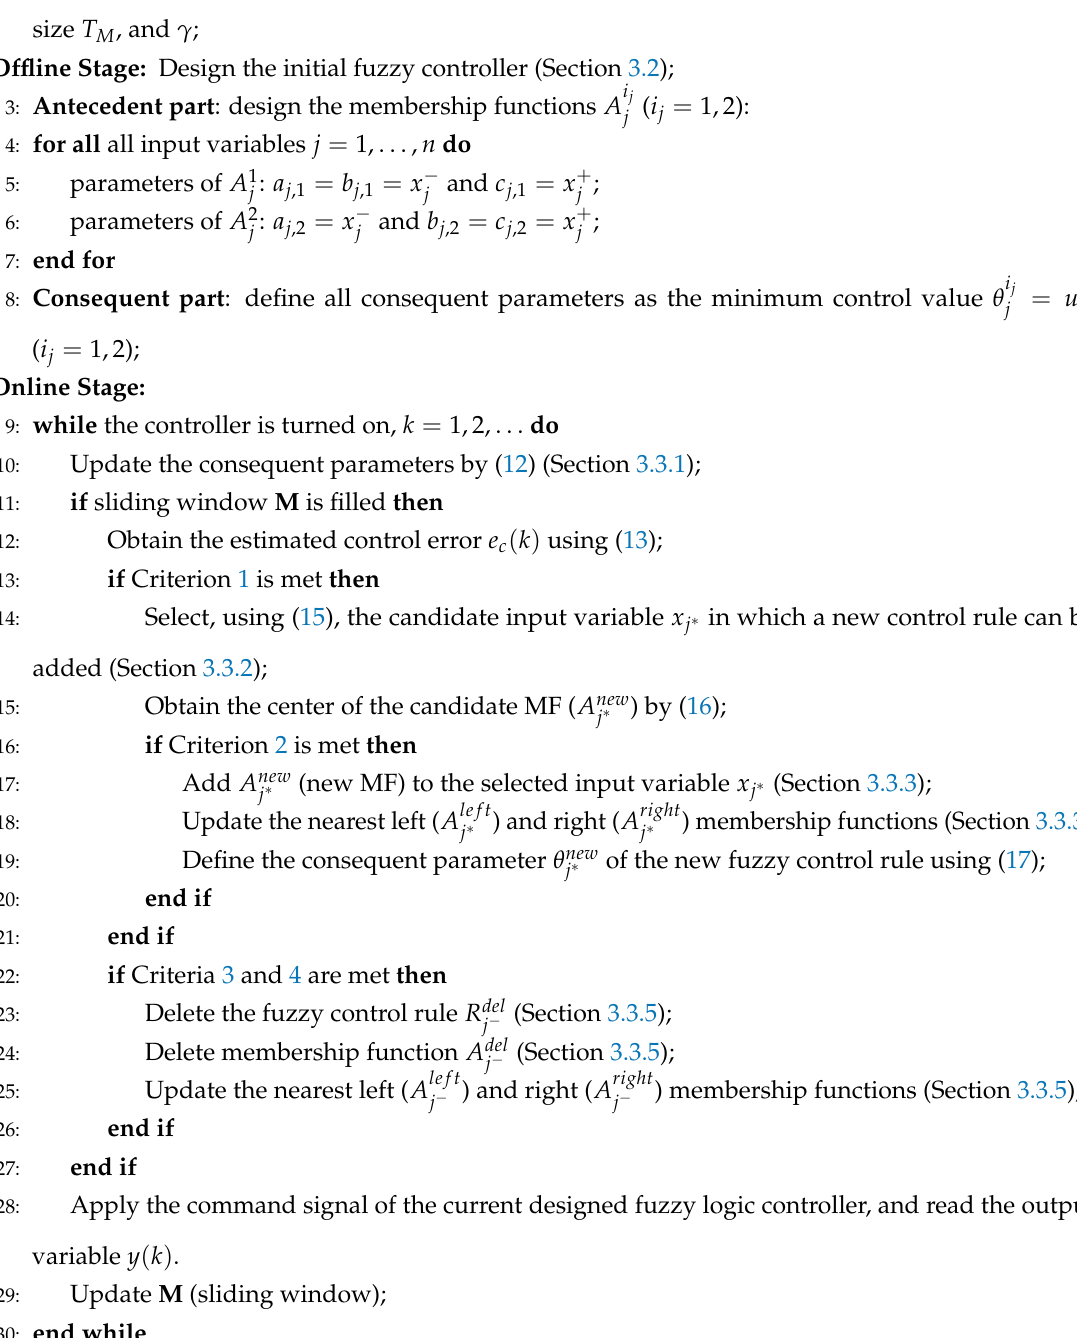
Algorithm 1 Proposed self-evolving FLC design